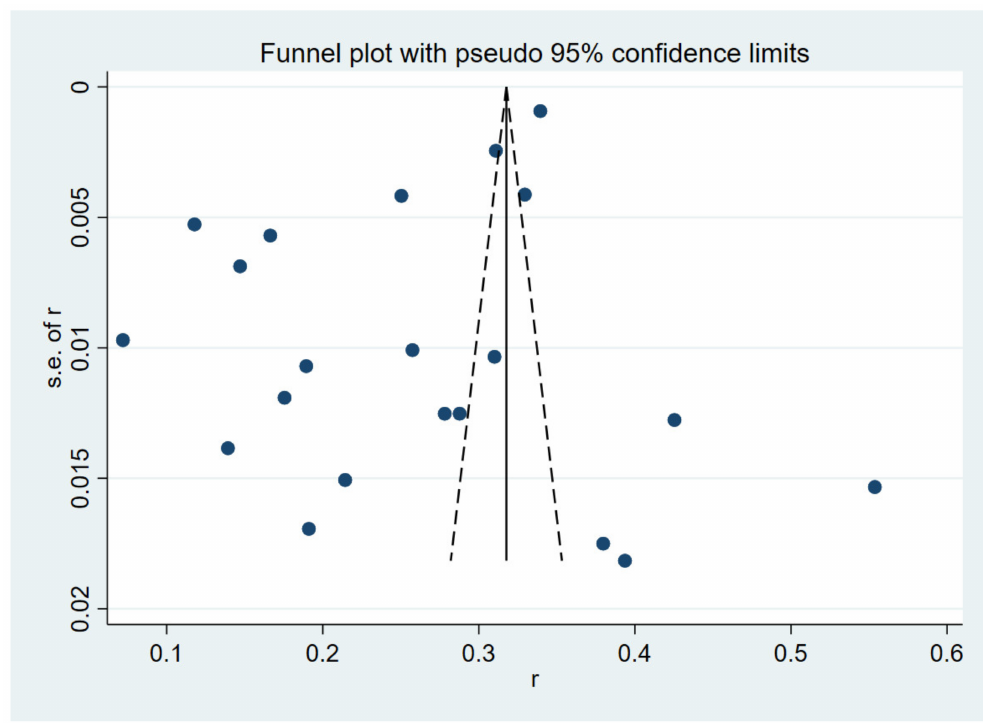
Figure 3. Funnel plot of the 21 studies included in the